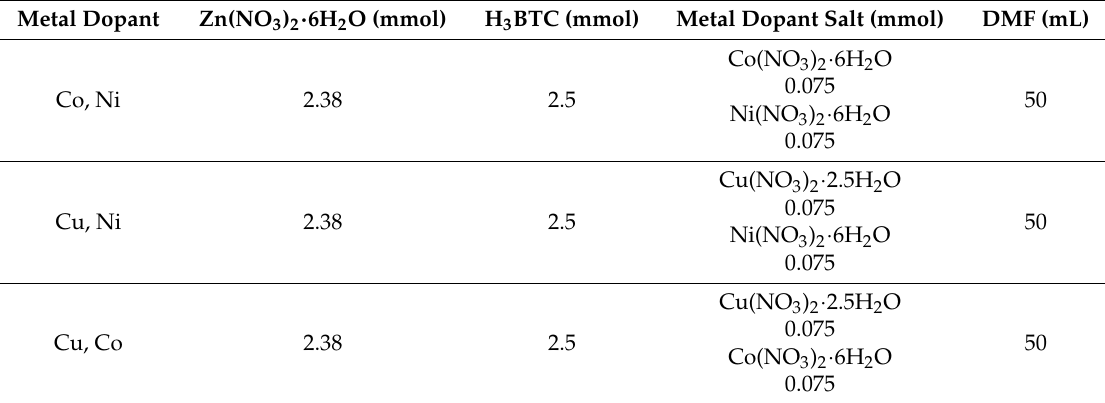
Table 2. Summary of reaction conditions for MOF synthesis: dual-metal doping {Zn-M 1 -M 2